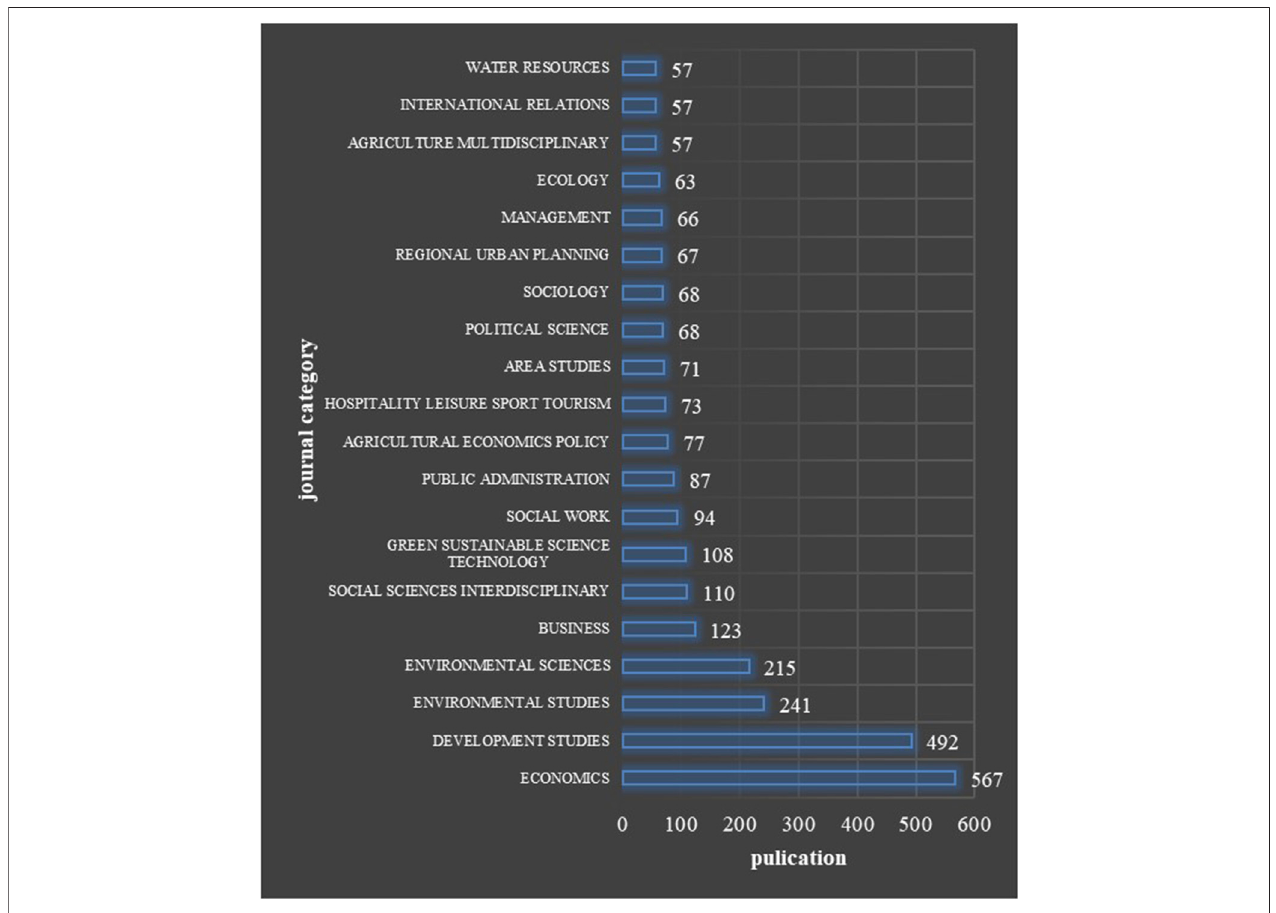
FIGURE 4 | Visualization of journal category from the web of